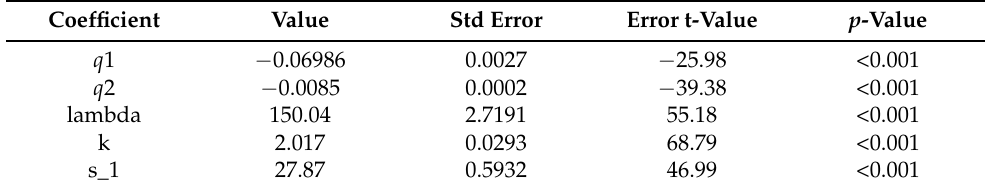
Table 4. Coefficient of the RR˜age model. The RMSE has a value of 1.738 kN/m on 7192 degrees of freedom.